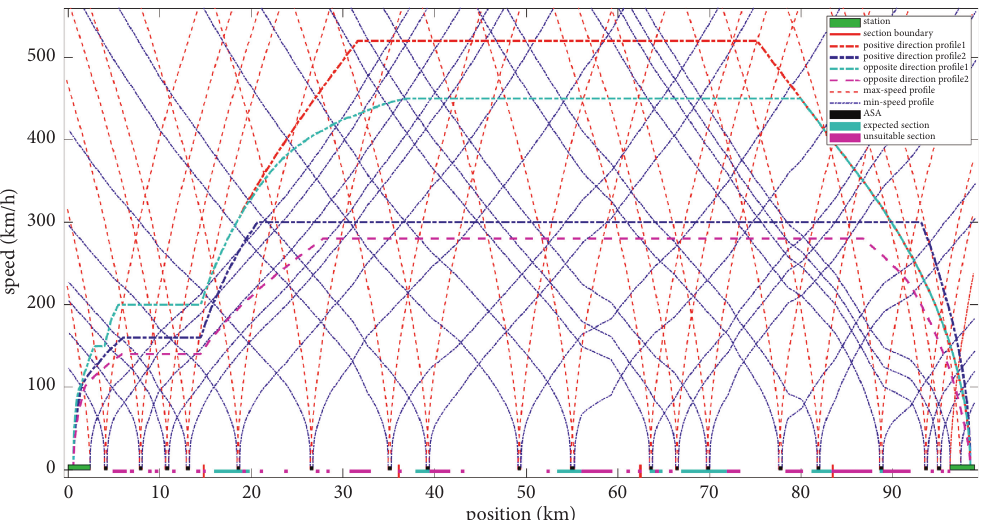
Figure 5: Result based on the optimized distribution (stepping redundancy time is 2s).